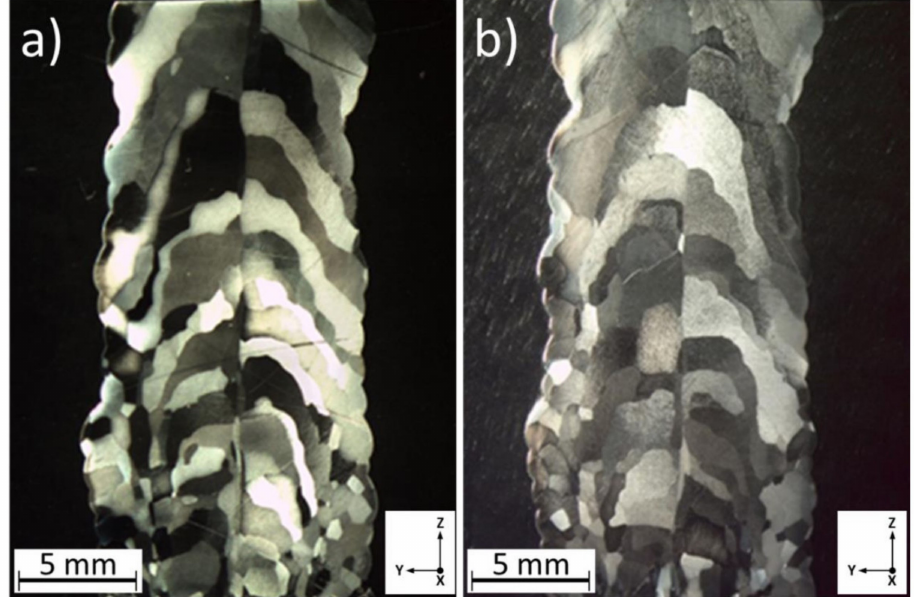
Figure 28. Microstructure of the front view of the as-deposited ( a ) and the heat-treated structure ( b )